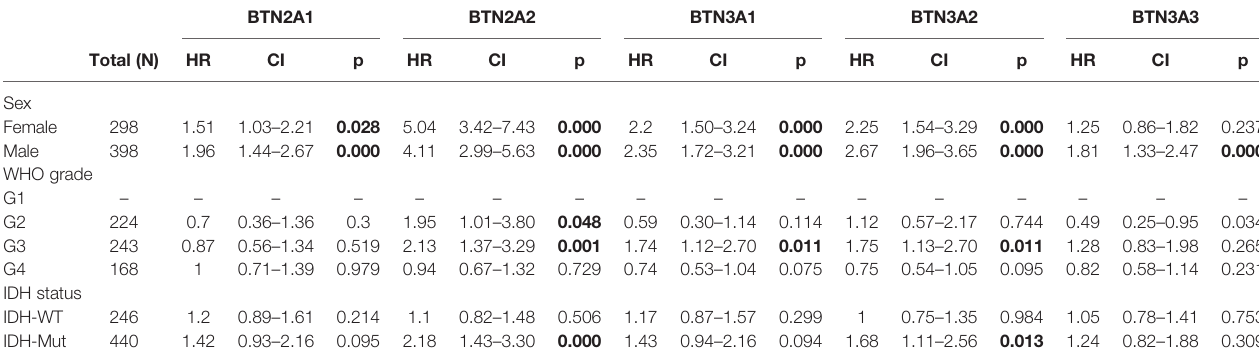
TABLE 1 | Correlation of BTN2/3 subfamily mRNA expression and clinical prognosis in GBMLGG with different clinicopathological